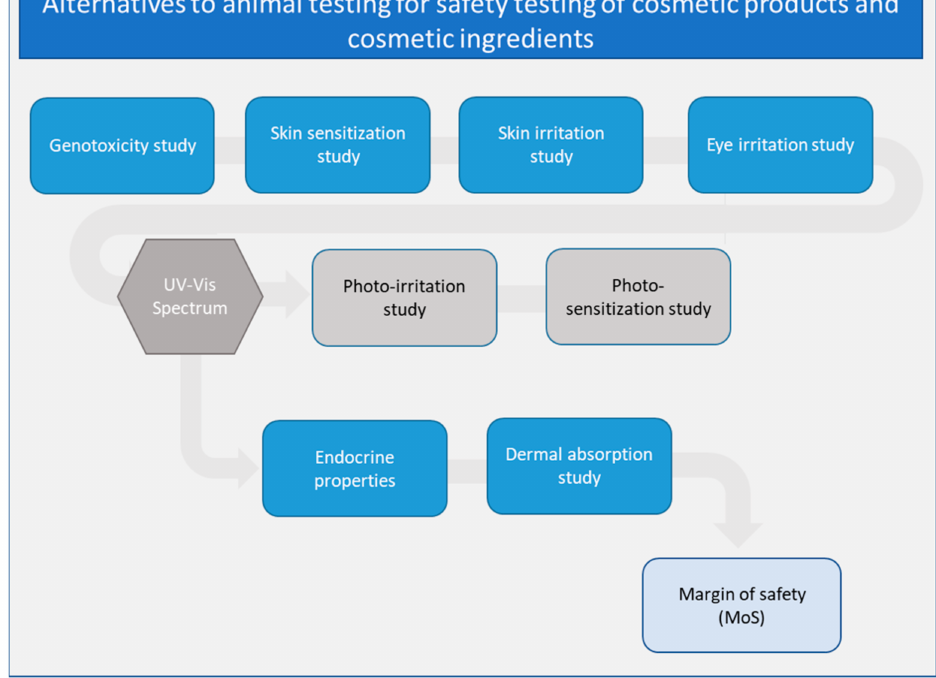
Figure 1. Overview of different alternatives to animal testing for safety assessment of cosmetic products and cosmetic ingredients. Assays in grey are not discussed in this